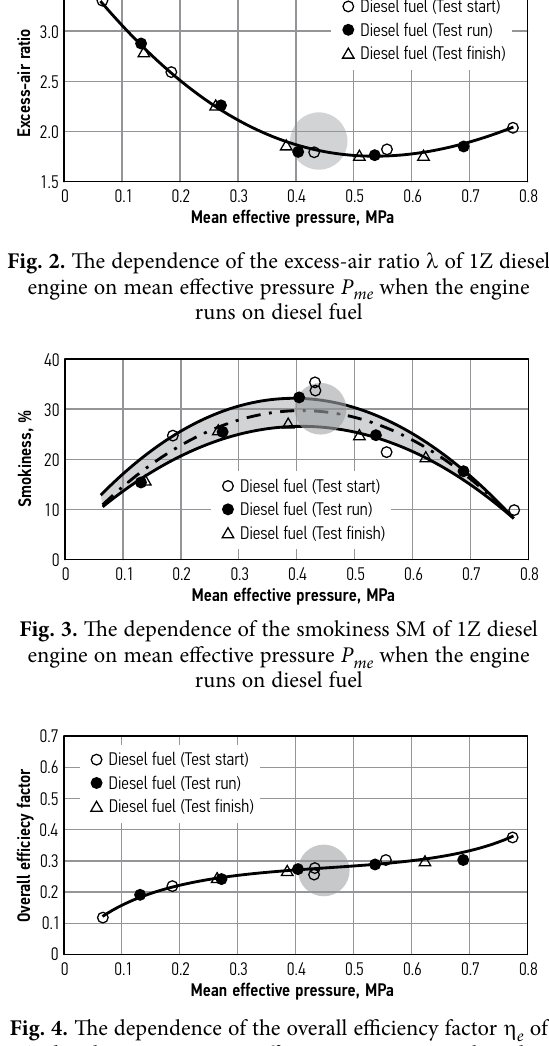
Fig. 4. The dependence of the overall efficiency factor η e of 1Z diesel engine on mean effective pressure P me when the engine runs on diesel fuel